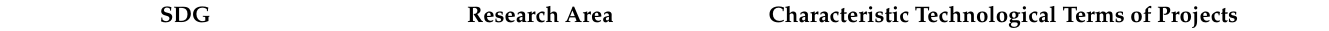
Table 7. Characteristic technological terms of projects for Industry, Innovation, and Infrastructure.